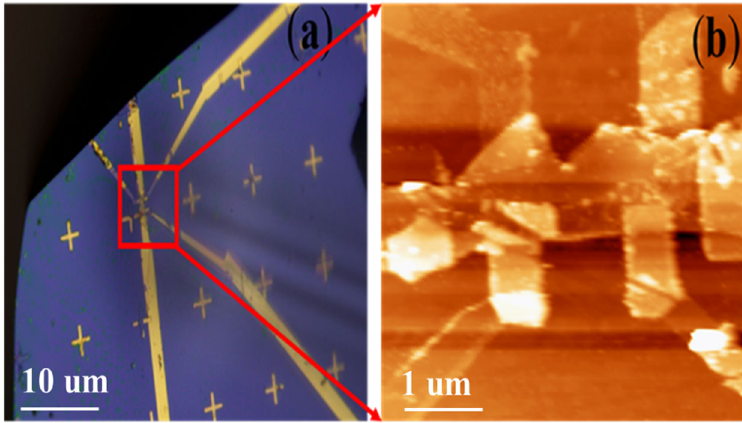
Figure 4. ( a ) An image of the sample under an optical microscope with a scale of 10 μ m. ( b ) MFM measurement topography by the scale bar is 1 μ m, measured at room temperature.